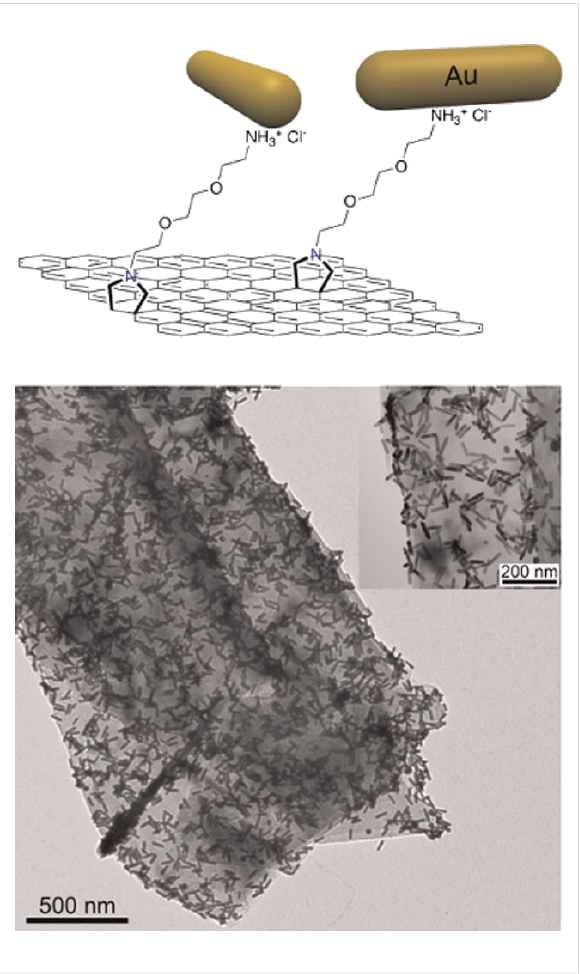
Figure 6: Graphene functionalization on the faces and edges by the 1,3-dipolar cycloaddition in DMF dispersions. Reproduced with permis- sion from [41], copyright 2010